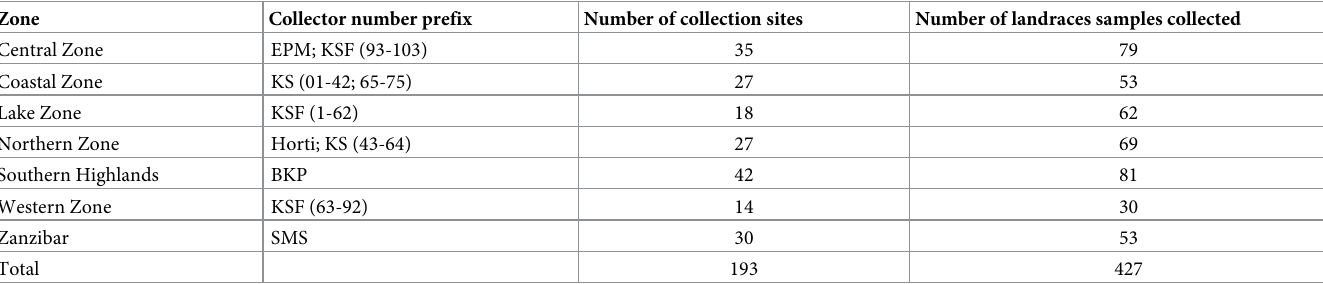
Table 1. Number of collection sites and landrace samples collected per geographical